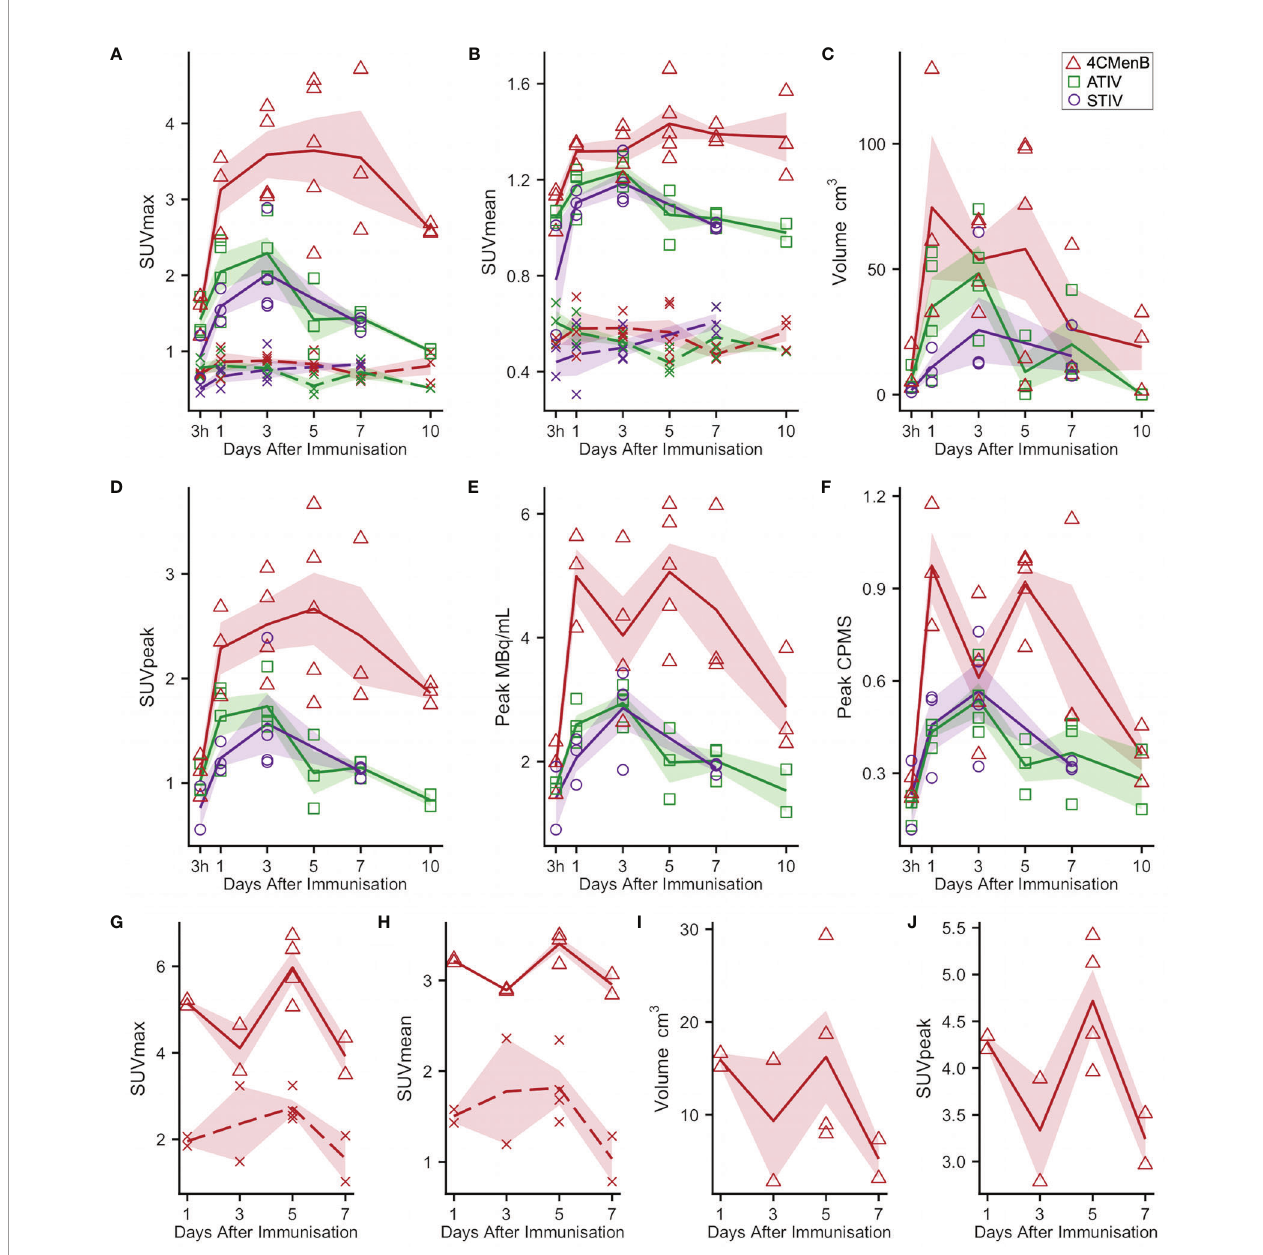
FIGURE 3 | Kinetics of injection site muscle PET/CT activity after immunization (A – F) 18 F-FDG PET/CT. Panels (G – J) : 11 C-PBR28 PET/CT. Each point indicates data from one participant immunized with 4CMenB (red triangles), ATIV (green squares) or STIV (purple circles). Lines indicate group mean by vaccine and day of scan, shaded area: SEM. For SUVmax and SUVmean: solid lines: immunized muscle; broken lines/crosses: contralateral